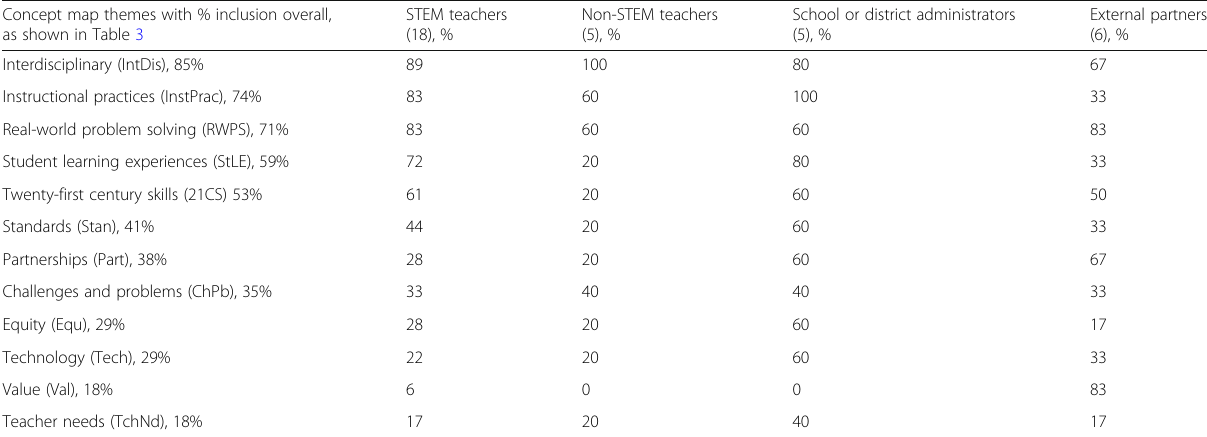
Table 5 Inclusion of themes by participants in each role group Concept map themes with % inclusion overall, as shown in Table